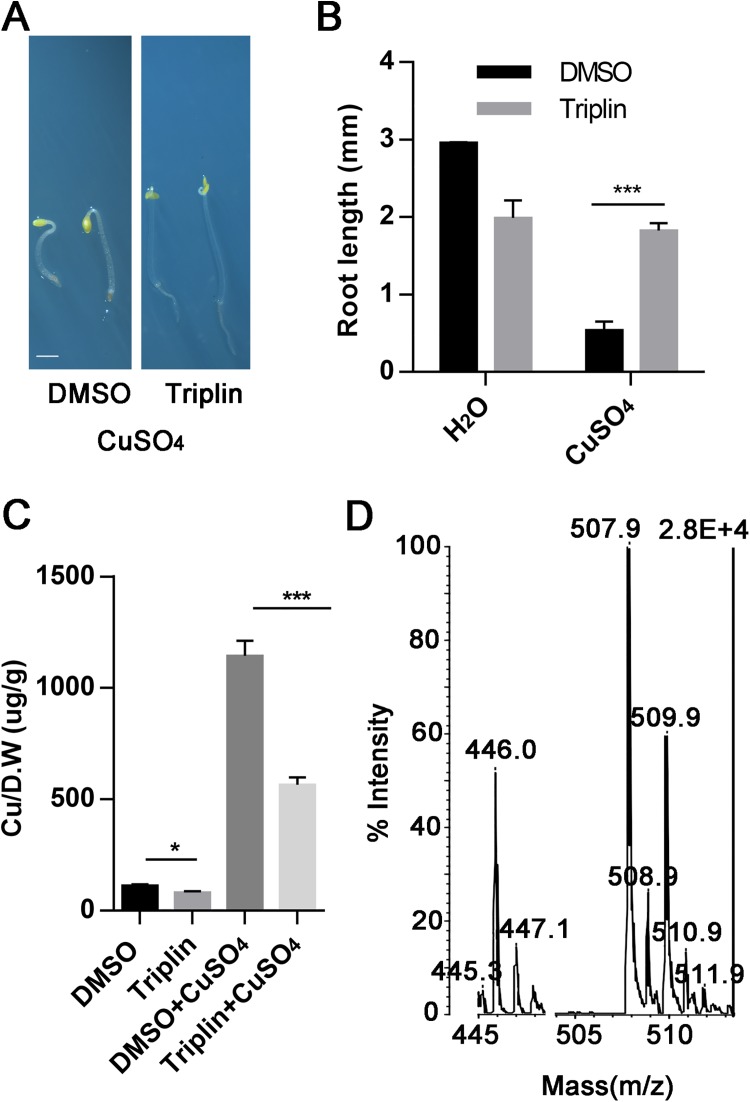
Triplin can chelate copper ions in vitro.(A) The phenotypes of 3-day-old, dark-grown seedlings of Col-0 treated with 50 μM CuSO4 in the presence of 1% (v/v) DMSO or 100 μM triplin. Scale bar represents 1 mm. (B) The root length of the seedlings as described in (A). Each experiment was repeated three times, more than 30 seedlings were used every time. Error bars represent SEM. (C) The relative copper contents of 3-day-old, dark-grown Col-0 seedlings on 0.5xMS growth medium with or without 100 μM triplin and/or 20 μM CuSO4. D.W represents dry weight of the seedlings. Each experiment was repeated three times (Error bars represent SEM). (D) MALDI-TOF-MS analysis of the mixture of equal volume of 100 μM CuSO4 and 100 μM triplin. Mr of triplin is 446.0g/mol. Mr of triplin+Cu is 510.0g/mol. *P < 0.05 and ***P < 0.0001 (two-tailed Student’s t-test) indicate a significant difference between groups of different treatments.